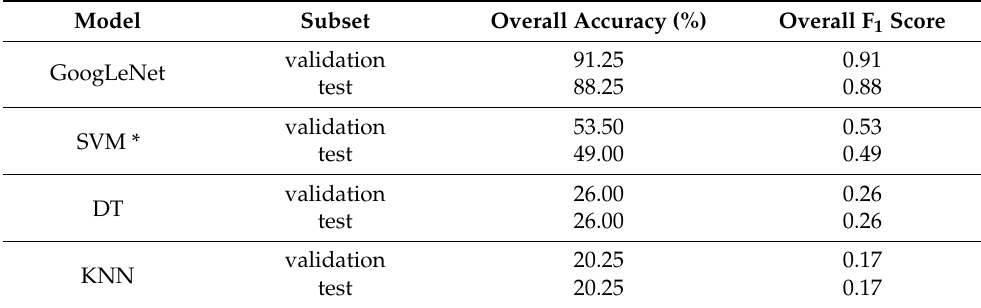
Table 5. Assessment results of accuracies of the GoogLeNet and three other ML